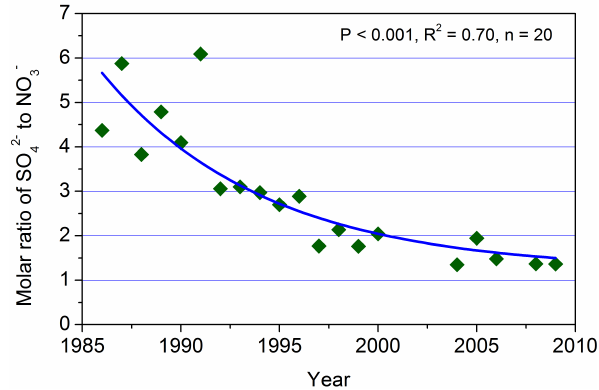
Fig. 1. Molar ratios of SO 2 − to NO − in precipitation in Guangzhou 4 3 City during the period from 1986 to 2009. Data are from Quan et al. (1992) for 1986 to 1990, Ye et al. (2008) for 1991 to 2000, Liu et al. (2006) for 2004, Huang et al. (2009) for 2005, Cao et al. (2009) for 2006, and this study for 2008 and